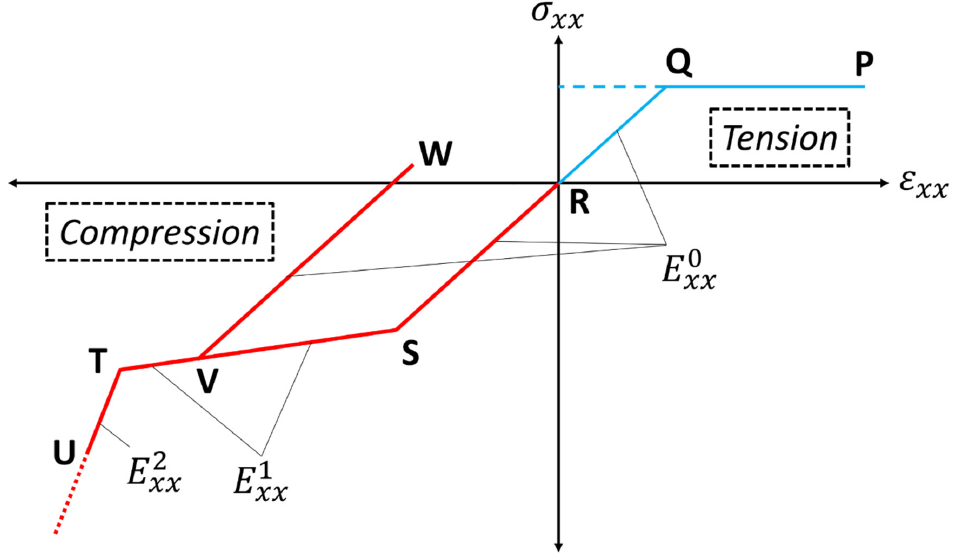
Figure 11. Tension/compression characteristic